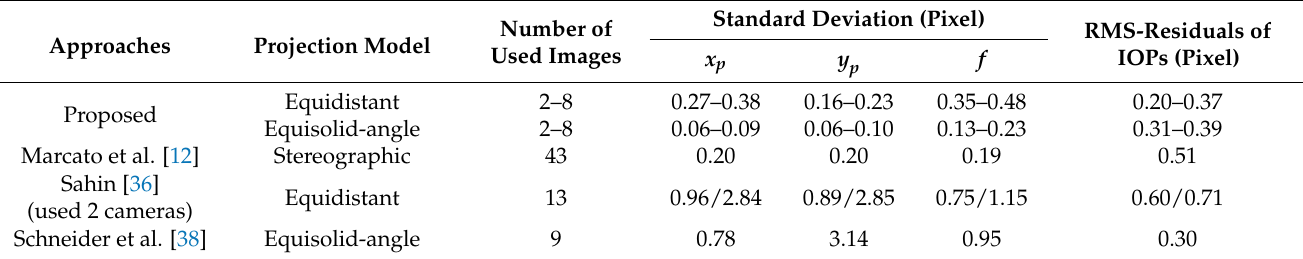
Table 19. Comparison with other self-calibration results using real